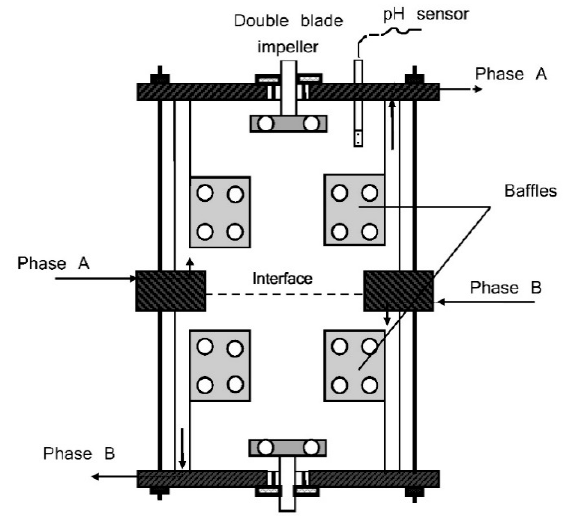
Figure 1. Extraction cell.